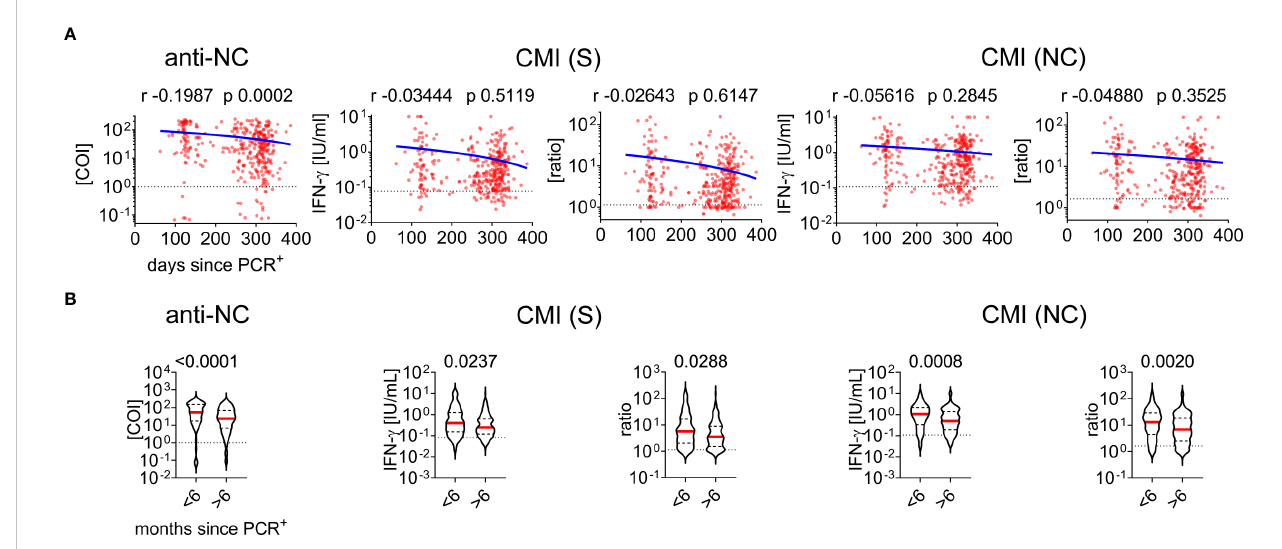
FIGURE 4 Cell-mediated immunity and antibody testing to SARS-CoV-2 in dependence of time between acute infection and measurement (A) Correlation of days since positive PCR testing versus measurements of CMI and antibodies as indicated. Calculated Spearman correlation results are provided for each diagram, blue lines indicate simple non-linear regression curves, dotted lines indicate cut-off values. (B) Comparative analysis of immunity in individuals infected less or more than six months before data acquisition. The Mann-Whitney test and p-value is provided above each diagram, dotted lines indicate corresponding cutoff